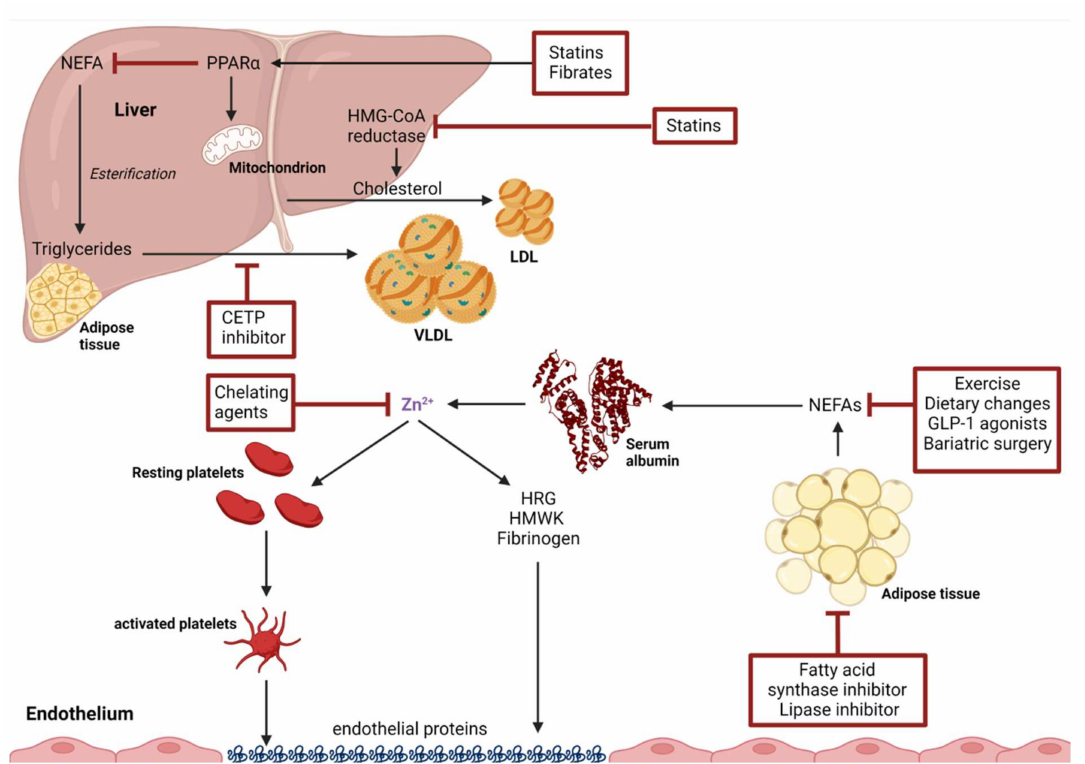
Figure 3. Summary of potential interventions targeting NEFA-mediated effects on plasma Zn 2+ handling. Adipose tissue cells contain fatty acid synthase, a potential drug target and a multidomain protein that converts acyl-CoA into palmitate. Breakdown of lipids stored in the tissue by hormone- sensitive lipase and adipose triglyceride lipase allows for the release of NEFAs into the bloodstream. Such enzymes are upregulated following exercise or in response to dietary changes. NEFAs are taken up by the liver and are esterified into triglycerides. PPAR- α acts to increase mitochondrial biogenesis and inhibits triglyceride synthesis. Fibrates and, to a lesser extent, statins both target PPAR- α by stimulating its expression. Statins also inhibit the synthesis of cholesterol and the release of low- density lipoproteins (LDL) by preventing the formation of mevalonic acid, a cholesterol precursor. The action of both statins and fibrates reduces plasma NEFA levels. Triglycerides are converted into very low-density lipoproteins (VLDL) by cholesteryl ester transfer proteins (CETP), a process that can be inhibited by specific CETP inhibitors. Chelating agents may be used to reduce the availability of Zn 2+ to bind haemostatic proteins such as HRG, HMWK and fibrinogen. Created using